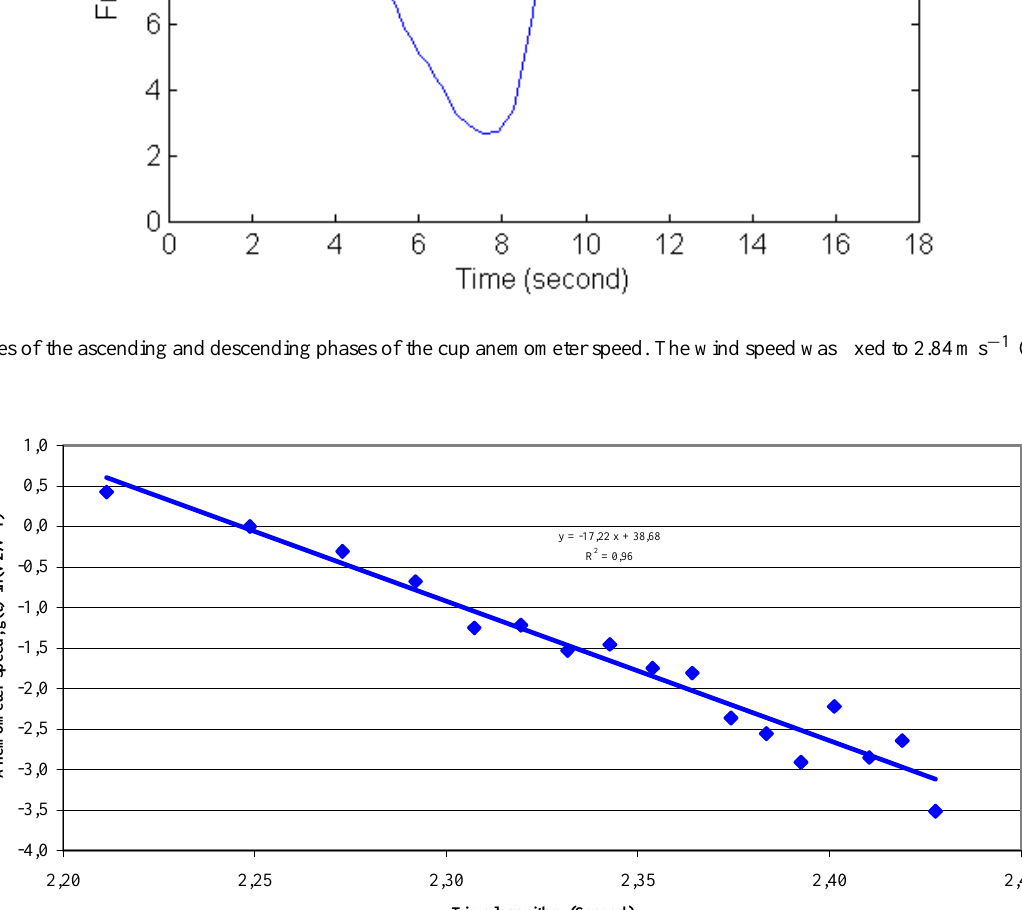
i) chart the anemometer velocity (in frequency) versus the